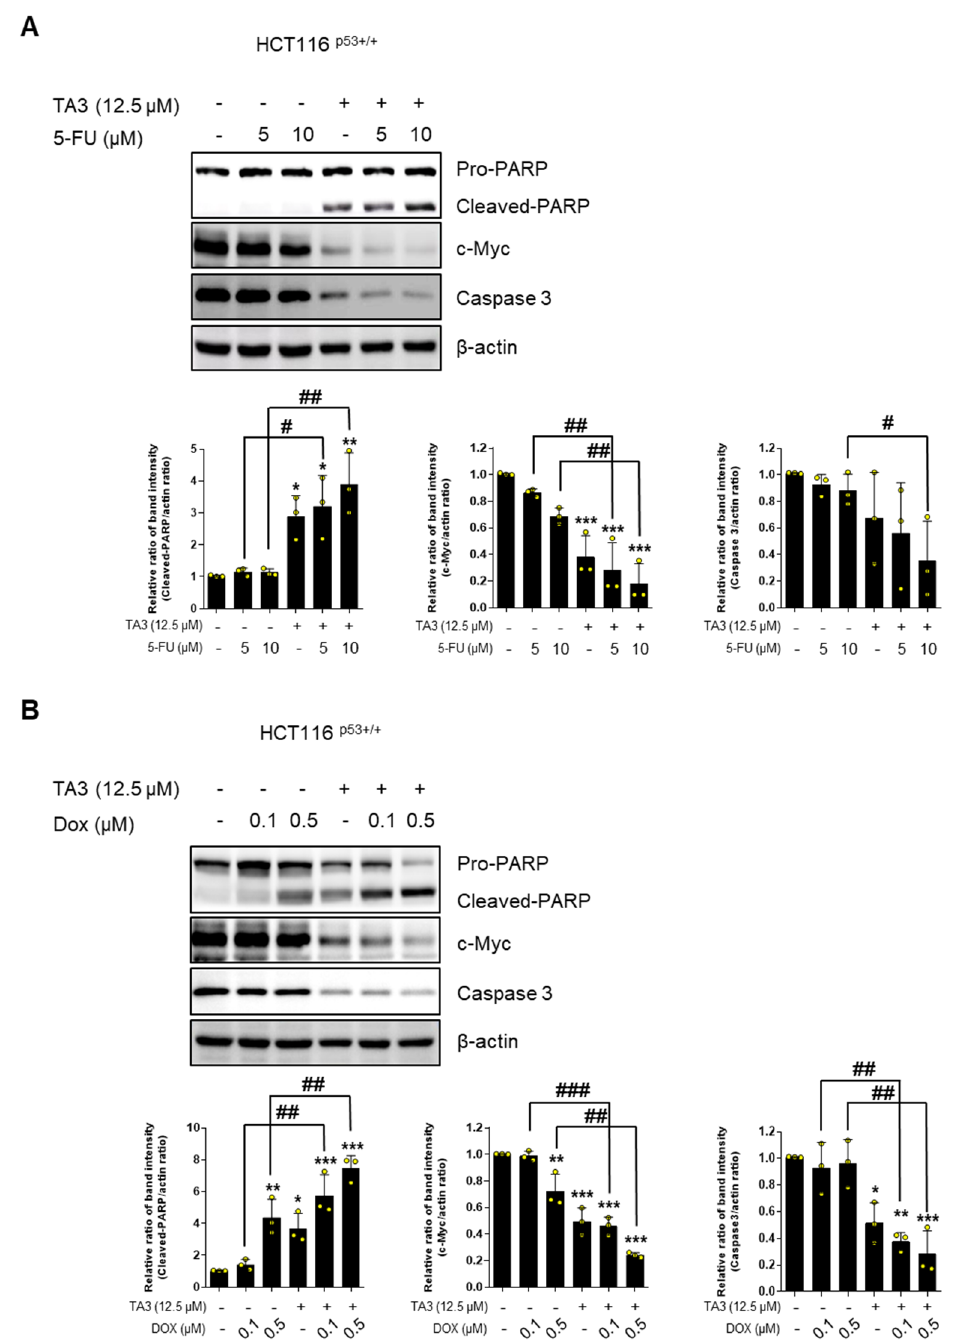
Figure 6. Combination therapy of TA3 with 5-FU or doxorubicin in HCT116 p53+/+ cells. ( A ) Cells were treated with TA3 (12.5 μM) for 24 h with or without 5-FU. ( B ) Cells were treated with TA3 (12.5 μM) for 24 h with or without doxorubicin. Statistical significance was analyzed using one-way analysis of variance (ANOVA) followed by Tukey’s test and the unpaired t-test. Quantification of protein expression is shown in the right panel. * p < 0.01, ** p < 0.005, *** p < 0.001 vs. control; # p < 0.01, ## p < 0.005, ### p < 0.001 vs. only 5-FU or DOX-treated group.